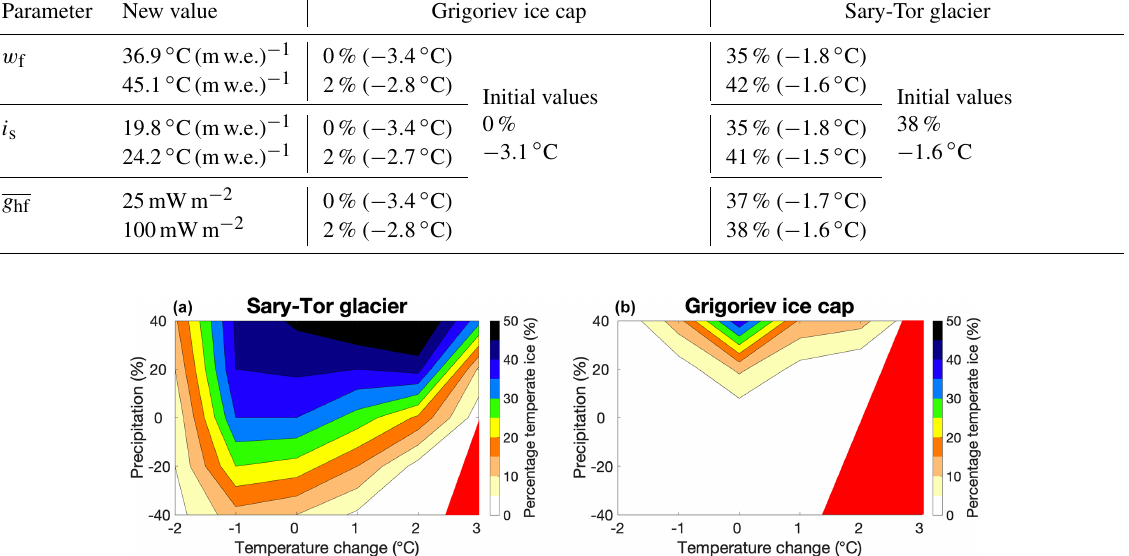
Figure 12. Fractional amount of temperate ice for different combinations of temperature and precipitation changes for the Sary-Tor glacier (a) and the Grigoriev ice cap (b) . For combinations in the red area, the ice mass disappears